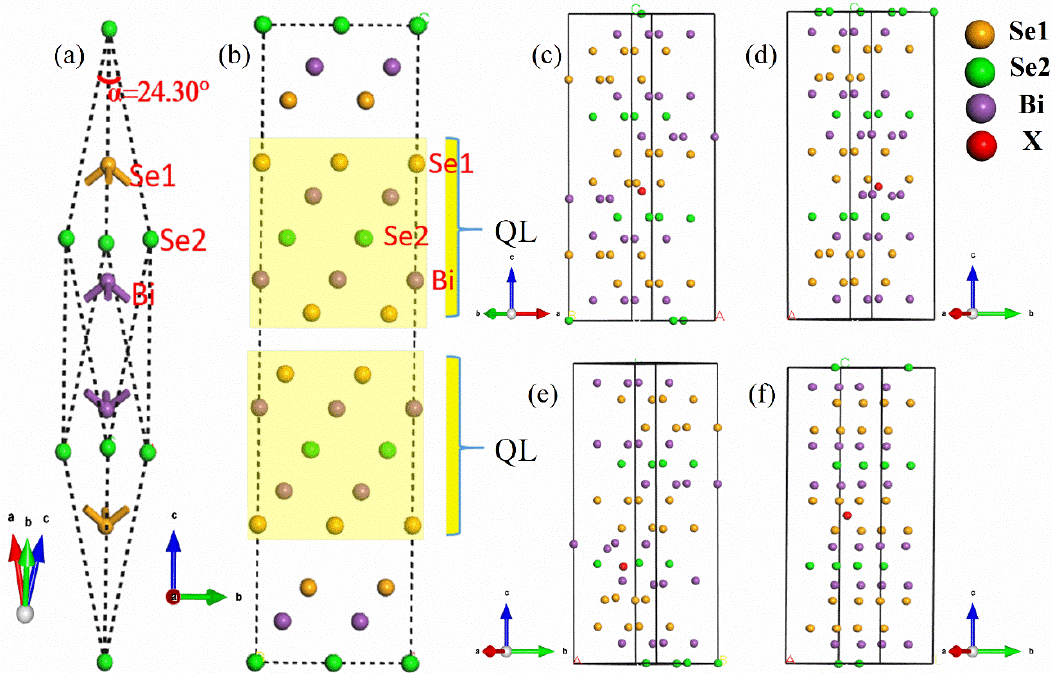
Figure 1. ( a ) The rhombohedral unit cell of Bi 2 Se 3 , ( b ) 60-atom layered crystal structure of Bi 2 Se 3 , ( c ) structure of Bi 23 Se 36 XBi, ( d ) structure of Bi 24 Se 35 XSe1, ( e ) structure of Bi 24 Se 35 XSe2, and ( f ) structure of Bi 24 Se 36 Xgap.